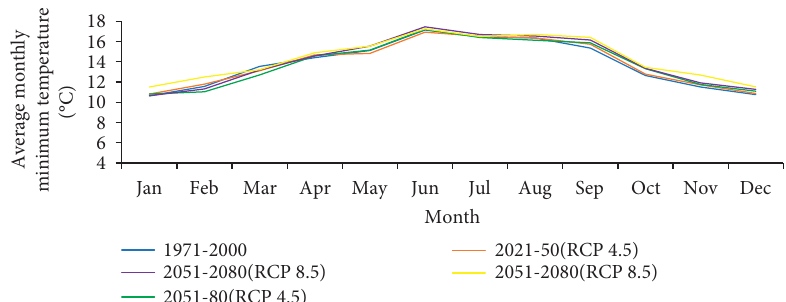
Figure 9: Average monthly minimum temperatures for future scenarios.